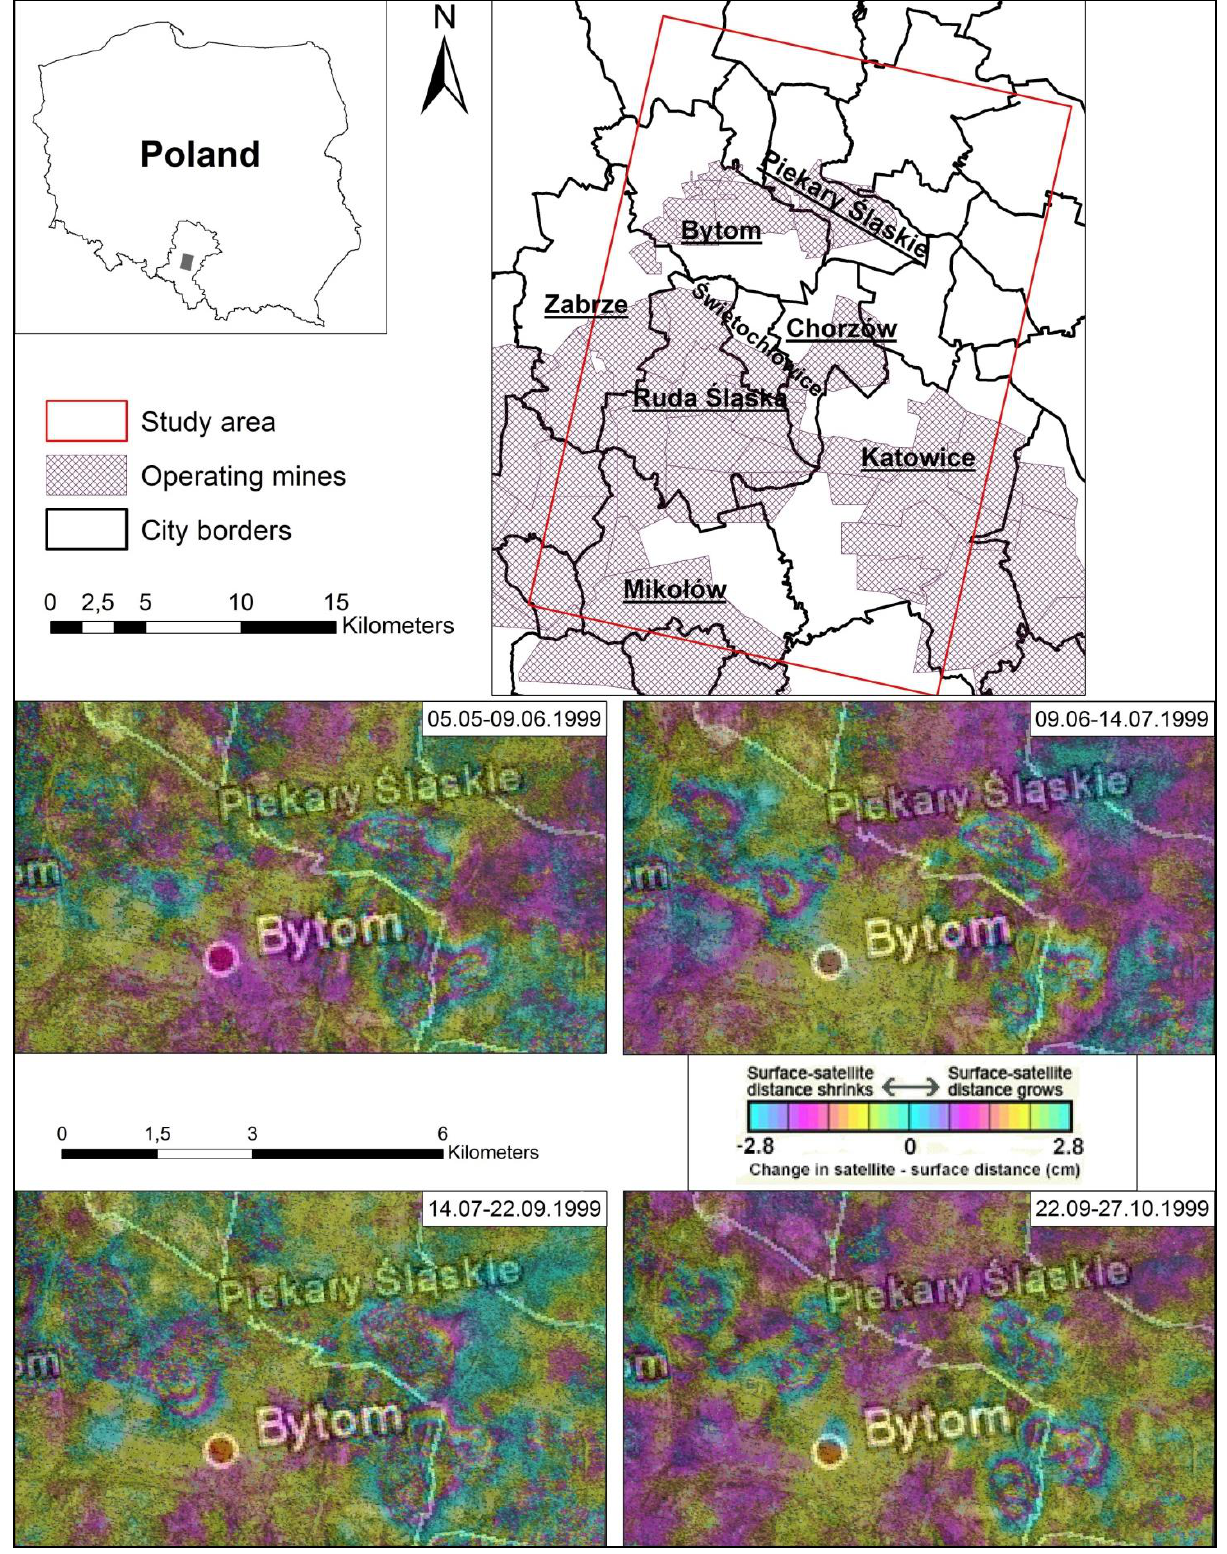
Fig. 1. The interferograms show well developed subsidence (fringes) under Bytom city in the monthly time ranges. Used images ERS-2 SAR, background map: